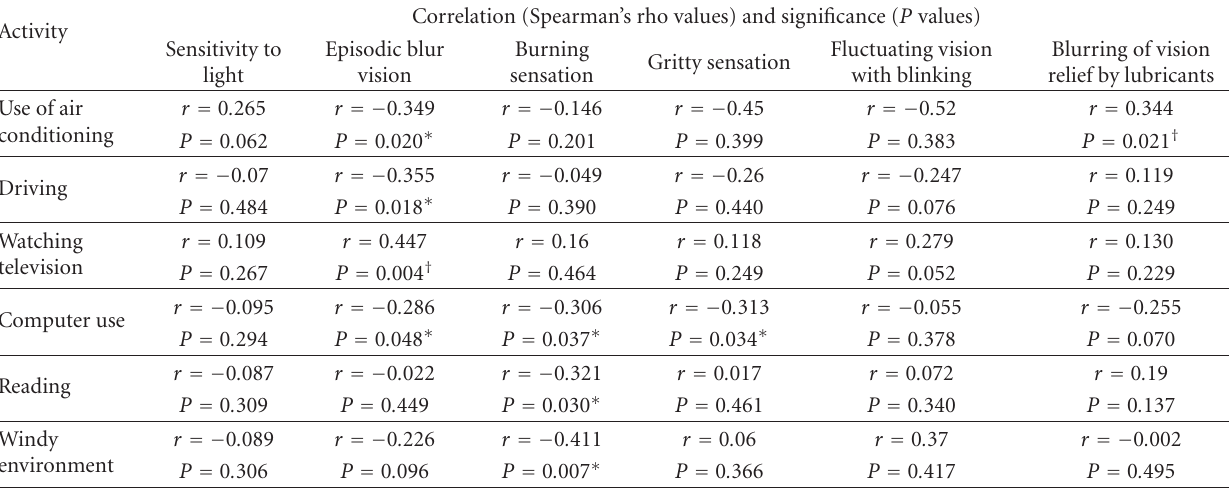
Table 2: Time spent for each item and correlations with DED symptoms. The table shows the Spearman’s rho ( r ) and P values. Correlation (Spearman’s rho values) and significance ( P Activity